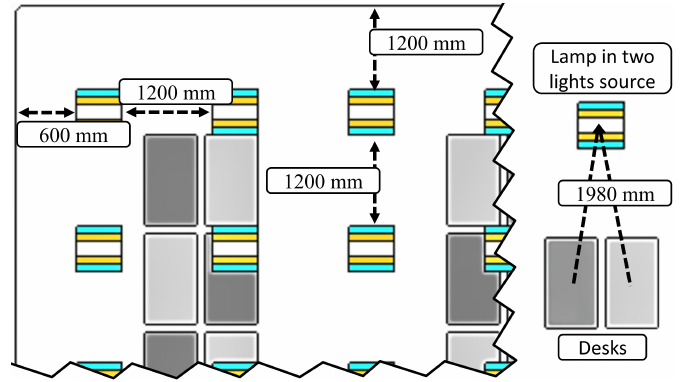
Figure 3. This is a part of the experiment, including 42 lights and 42